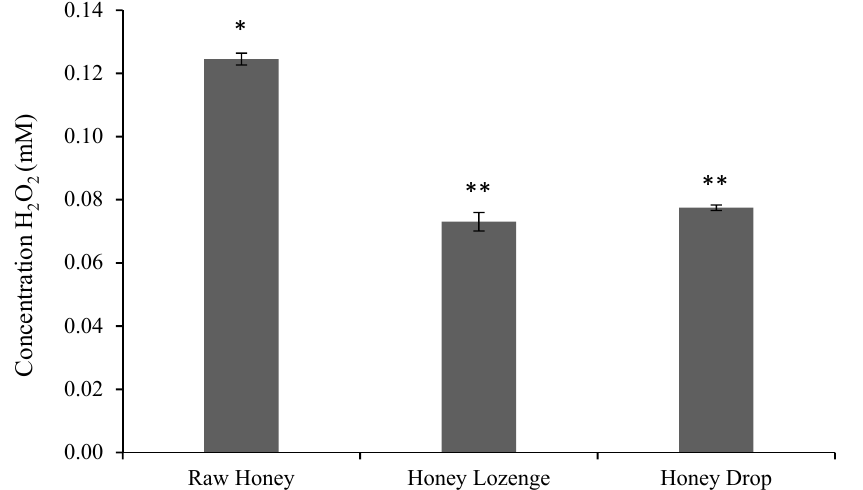
Figure 1. Hydrogen peroxide concentration in honey samples (mM/g of honey), as determined by Amplex ® Red Hydrogen Peroxide/Peroxidase assay. The assay was performed at a concentration of 0.5 g honey/mL of reaction buffer. Bars with a different number of symbols (* and ** represent statistically different samples).